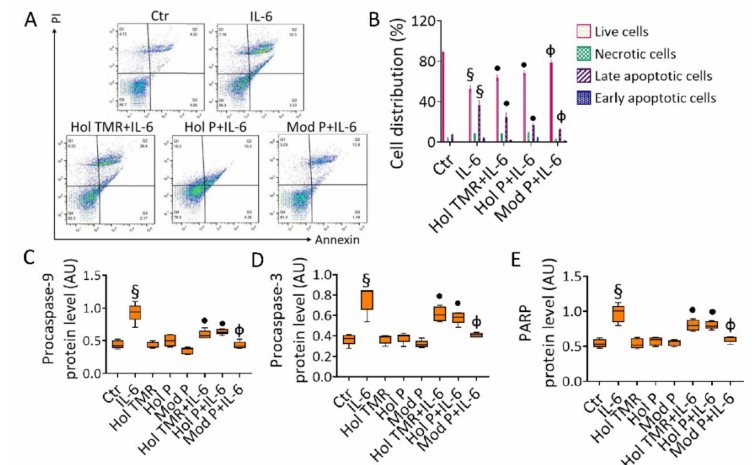
Figure 4. Milk extract effects on cell death. ( A ) Representative dot plots and ( B ) FACS analyses of Annexin V-FITC and Propidium Iodide (PI)-stained ECs treated with Hol TMR, Hol P, and Mod P milk (20% v / v ) for 72 h, IL-6 (20 ng/mL) for 24 h, or pretreated for 16 h with milk before starting stimulation for 24 h with IL-6. Control cells (Ctr) were treated with the corresponding highest volume of HBSS-10 mM Hepes. Western blotting analysis of ( C ) procaspase-9, ( D ) procaspase-3, and ( E ) PARP expression levels represented as boxplots of densitometric mean values, expressed as arbitrary units (AU) of n = 5 independent experiments: § p < 0.001 vs. Ctr; • p < 0.05 vs. IL-6; Φ p < 0.01 vs. IL-6.